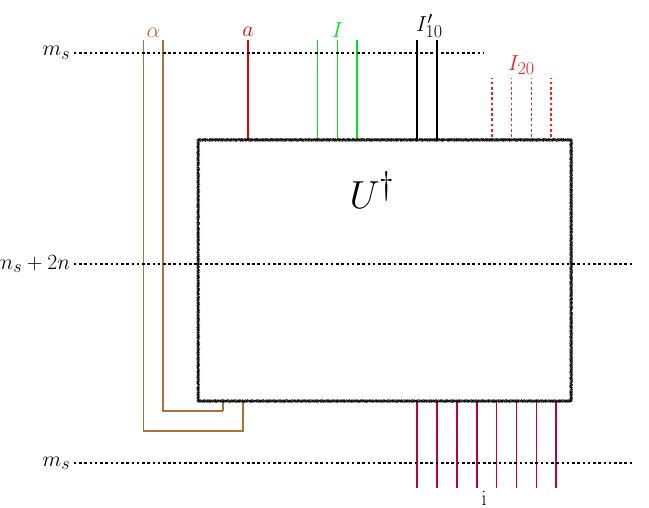
Figure 8 . We draw the ˜ U † operation in terms of U † . One requires postselection of the 2 n I 0 qubits to the | I 20 i state. These legs are denoted by dotted lines. In addition, the number of the i -qubits is denoted by m s (= log | i | ) 2